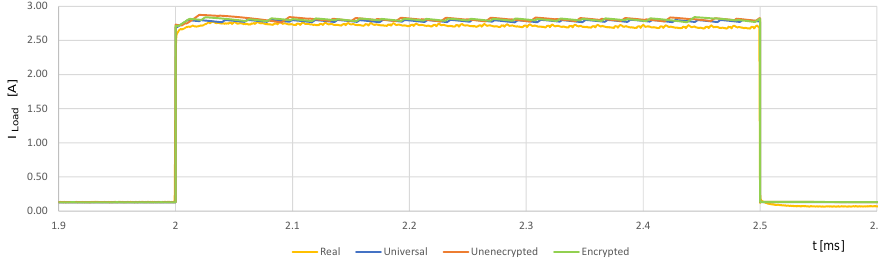
Figure 24. I Load models and real measurement time graph curves in case of dynamic load.